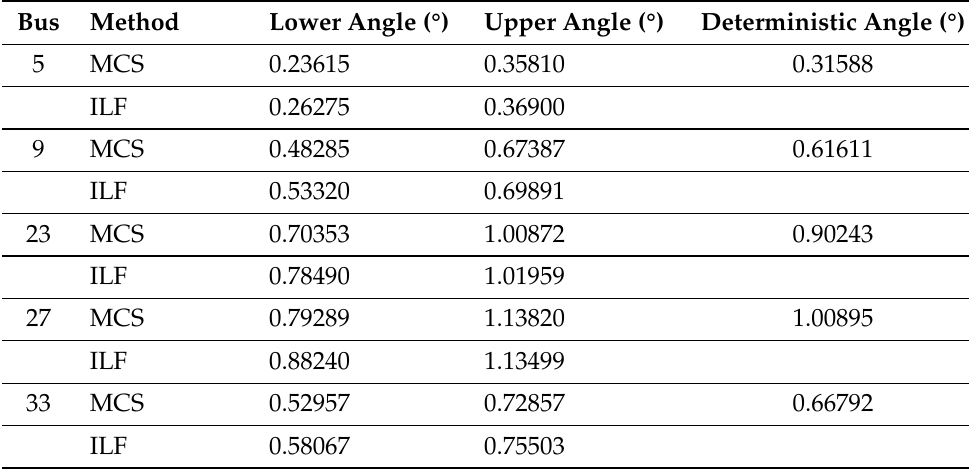
Table 1. Phase Angle—IEEE 34-bus test system.